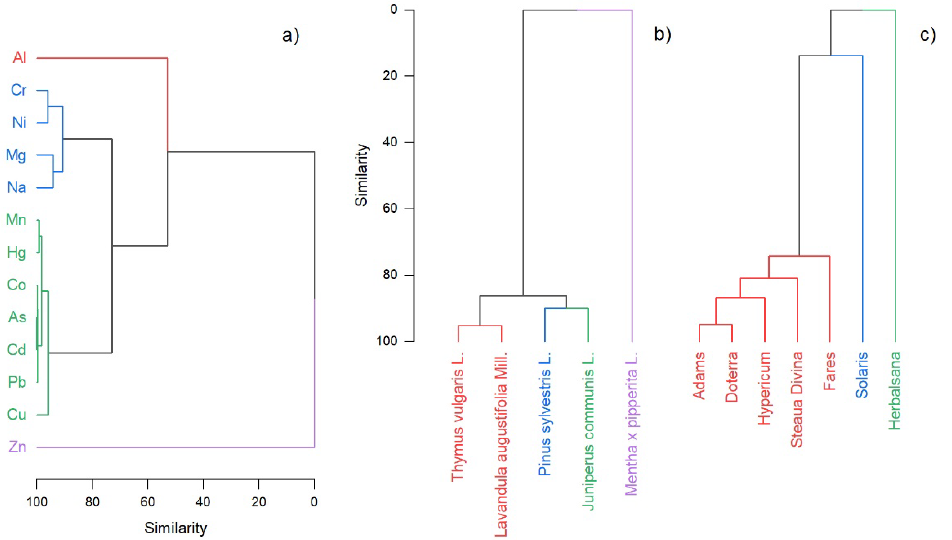
Figure 5. Hierarchical cluster analysis of heavy metals in different plant essential oil product cate- gories: ( a ) based on the maximum heavy metal concentration, ( b ) association based on plant species used for essential oil extraction, and ( c ) grouping based on the producer.